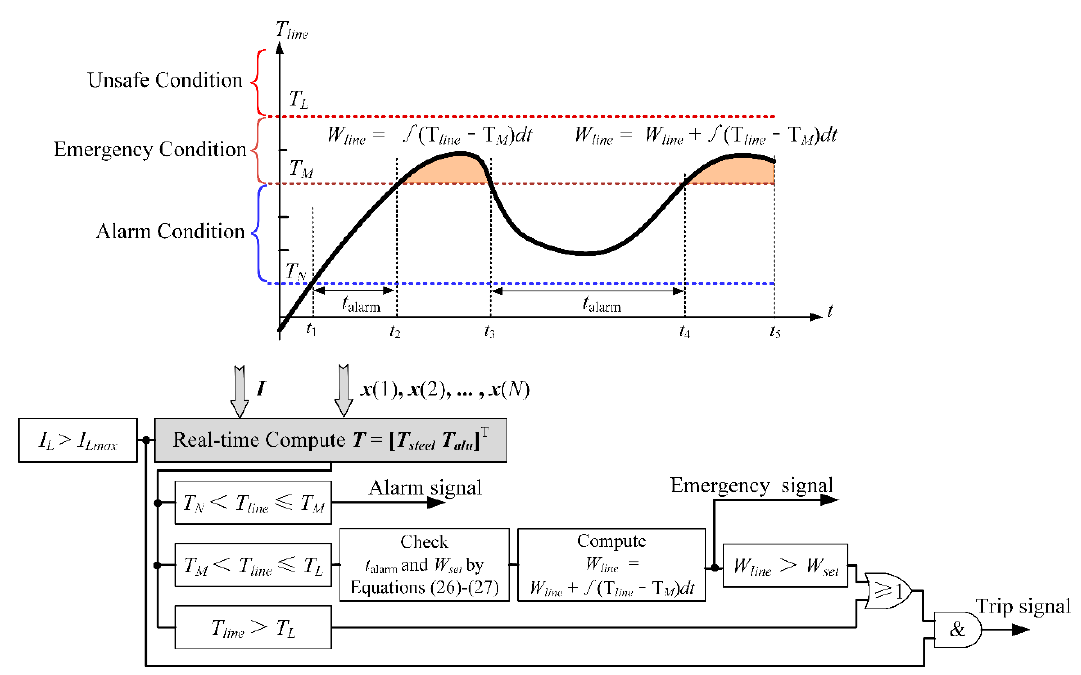
Figure 10. Logic block diagram of the MPTP based on transient temperature of overhead transmission lines.